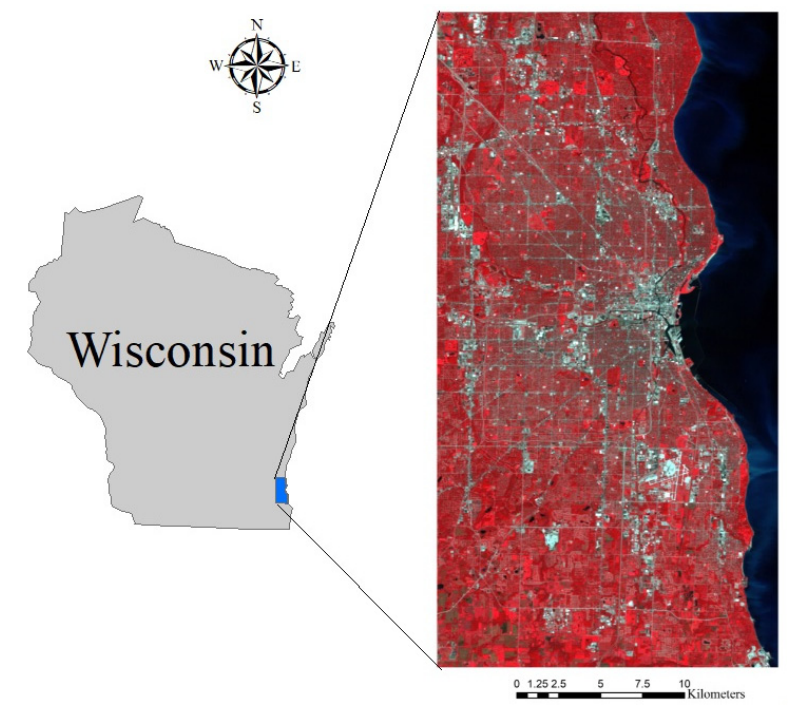
Figure 1. The study site: Milwaukee County, WI, USA.